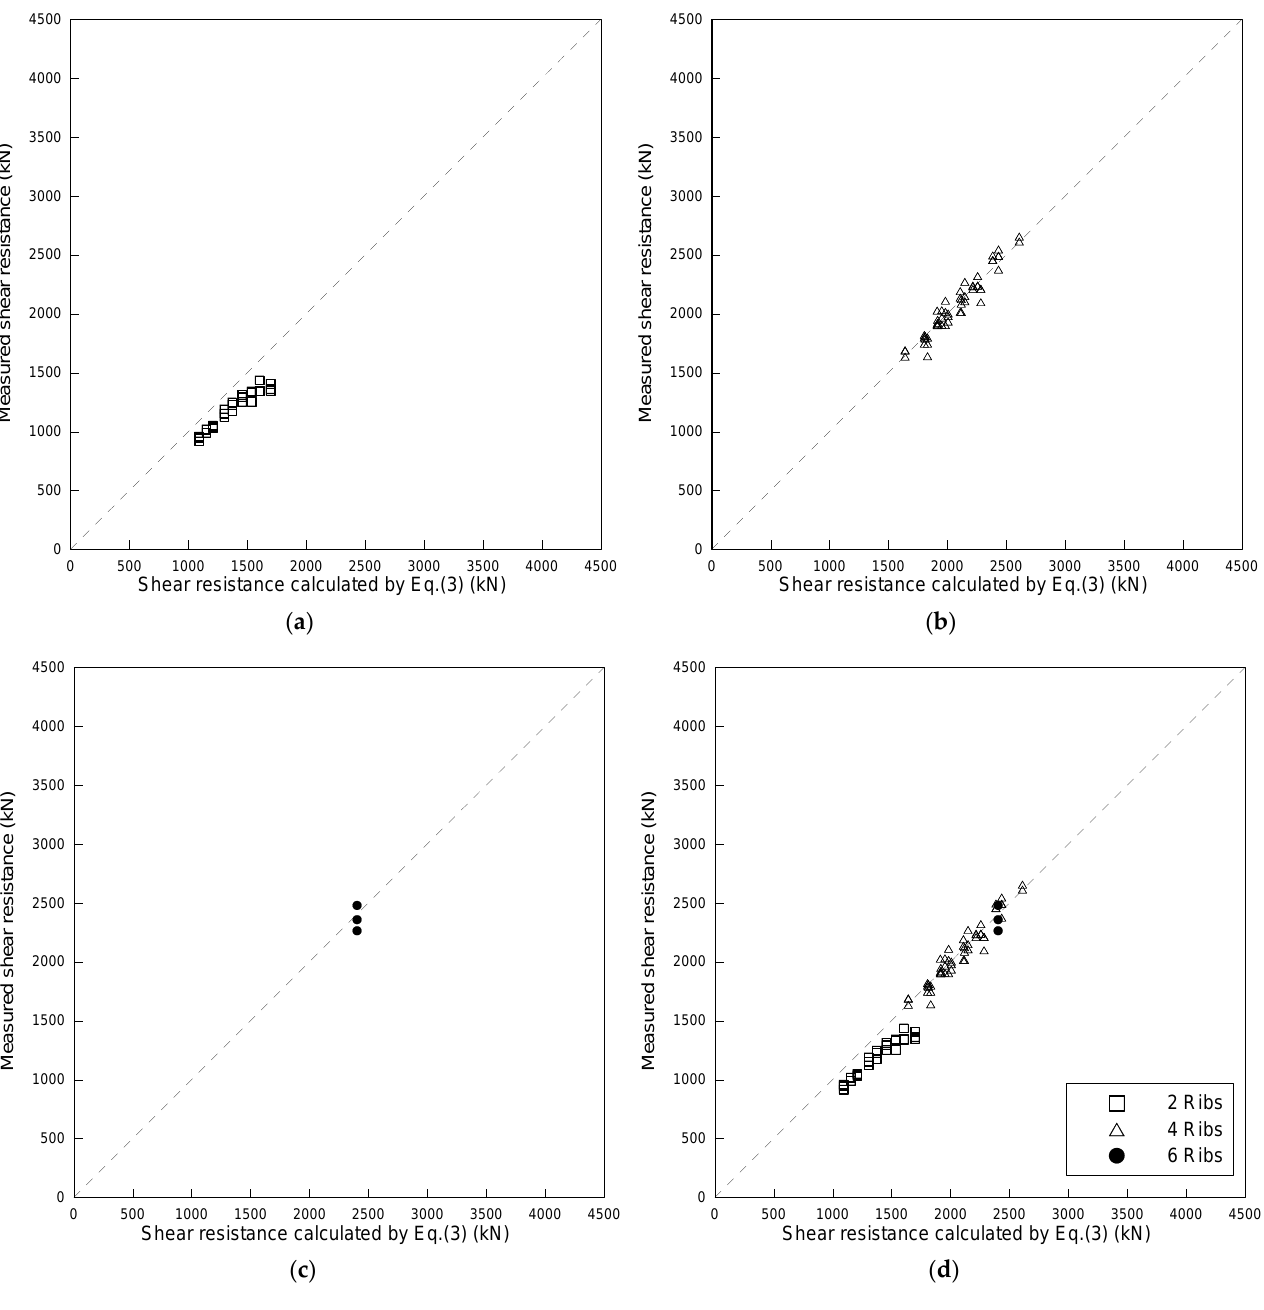
rib (3 data: Figure 5c), and total (84 data: Figure 5d). The estimation resistance is calculated with the nominal values for all design variables except the concrete compressive strength, which is adopted from the cylinder tests for the test specimens.